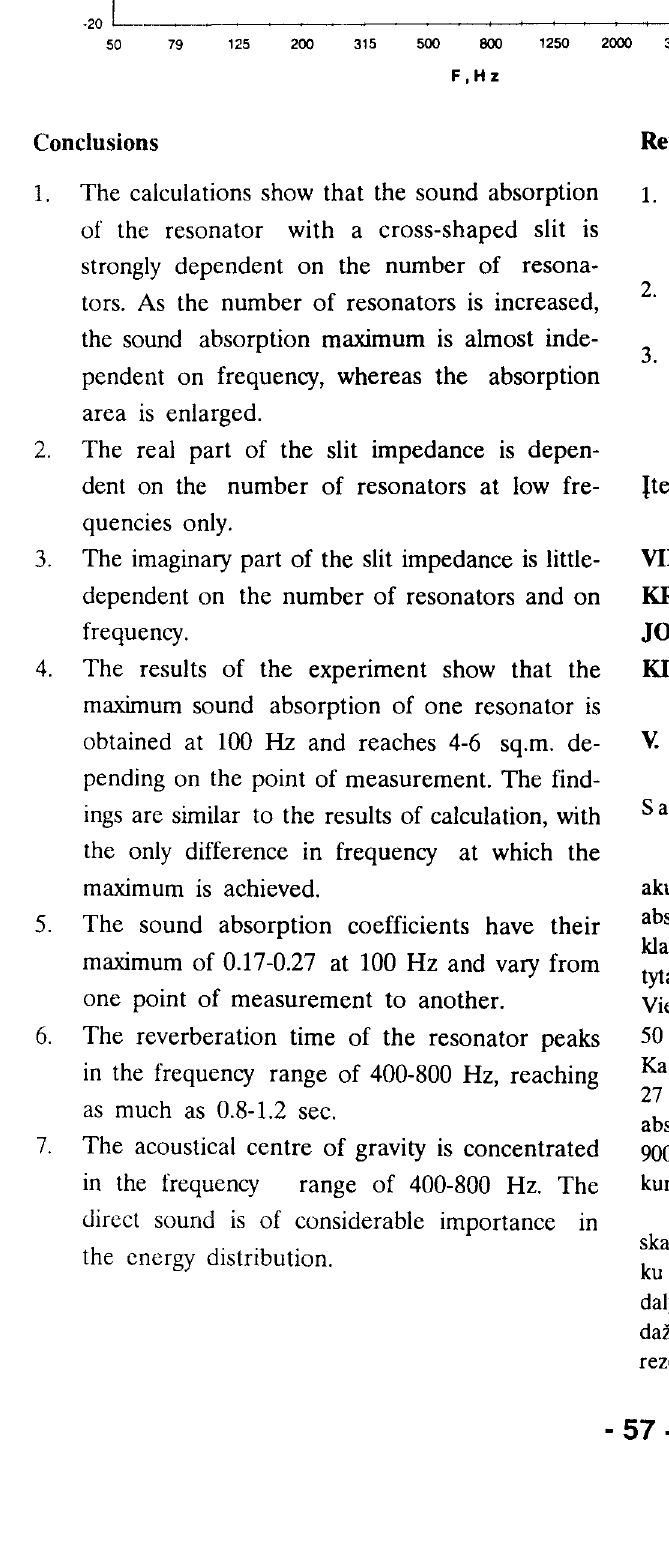
Fig. 11. The frequency-depen dence of the sound energy rela tionship in the resonator with a cross-shaped slit. I, 2, 3 - mea surement